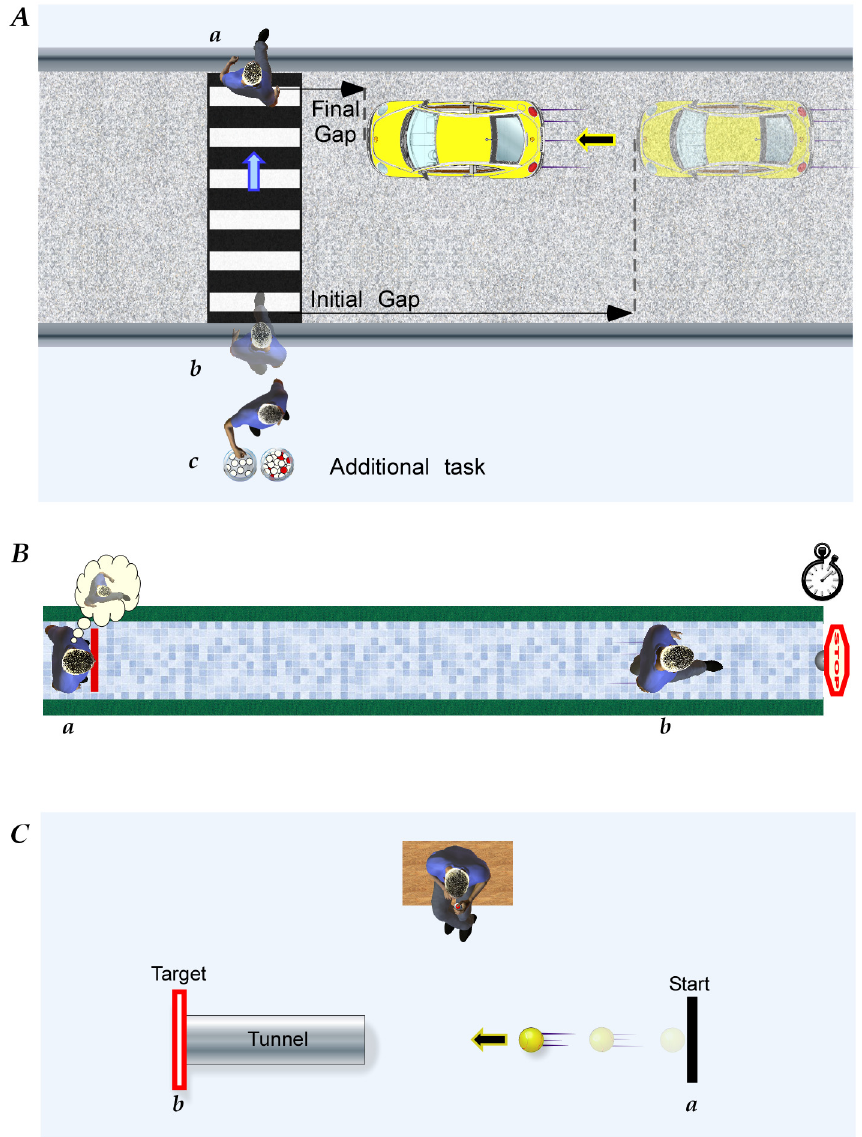
Fig 1. Methods. A. Study 1: Road Crossing. After crossing the road ( a ! b ), participants waited, either at the road edge ( free crossing ) or performing the ball-gathering task ( task crossing ) at c . On the return, crossing in front of the oncoming car ( b ! a ), the initial and final gaps to the car were measured. B. Study 2: Perceived time to walk to a target. Participants stood at the end of a 5m or 10m path ( a ) and imagined walking to the end, and indicated when they arrived. They then walked the paths ( b ) and the actual time taken was measured. C. Study 3: Perceived time-to-arrival of a moving object. Projected onto the floor was a virtual “ ball ” that left the start line ( a ) and moved towards a target ( b ) at constant speed. Before reaching the target it disappeared into a tunnel. Participants indicated with a finger press the time they estimated the ball would reach the